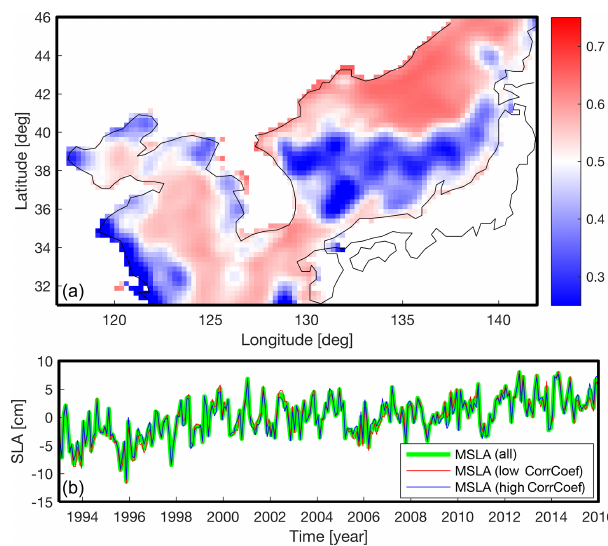
Figure 2. (a) Linear trend map of sea level anomalies around the Korean Peninsula from AVISO without annual signal from 1993 to 2015 (the red-colored area has a higher linear trend than 3.0mmyr − 1 , and the blue-colored area has a lower linear trend than 3.0mmyr − 1 ); (b) spatial mean time series of sea level anomalies around the Korean Peninsula (red) and global (blue) from AVISO without annual signal.